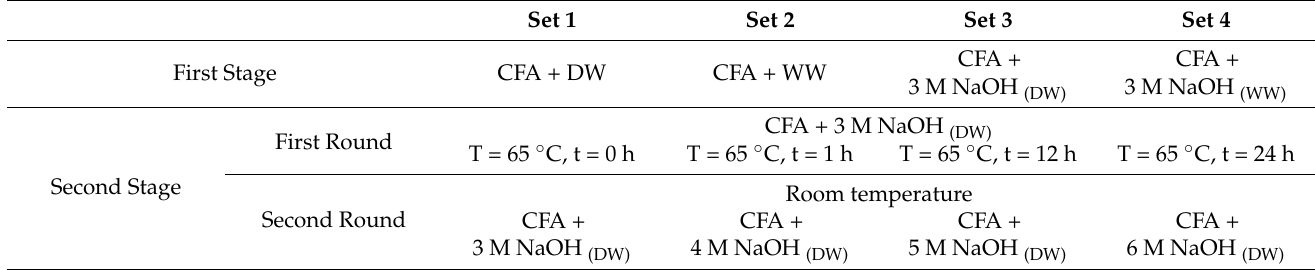
Table 3. Zeolite synthesis experiment